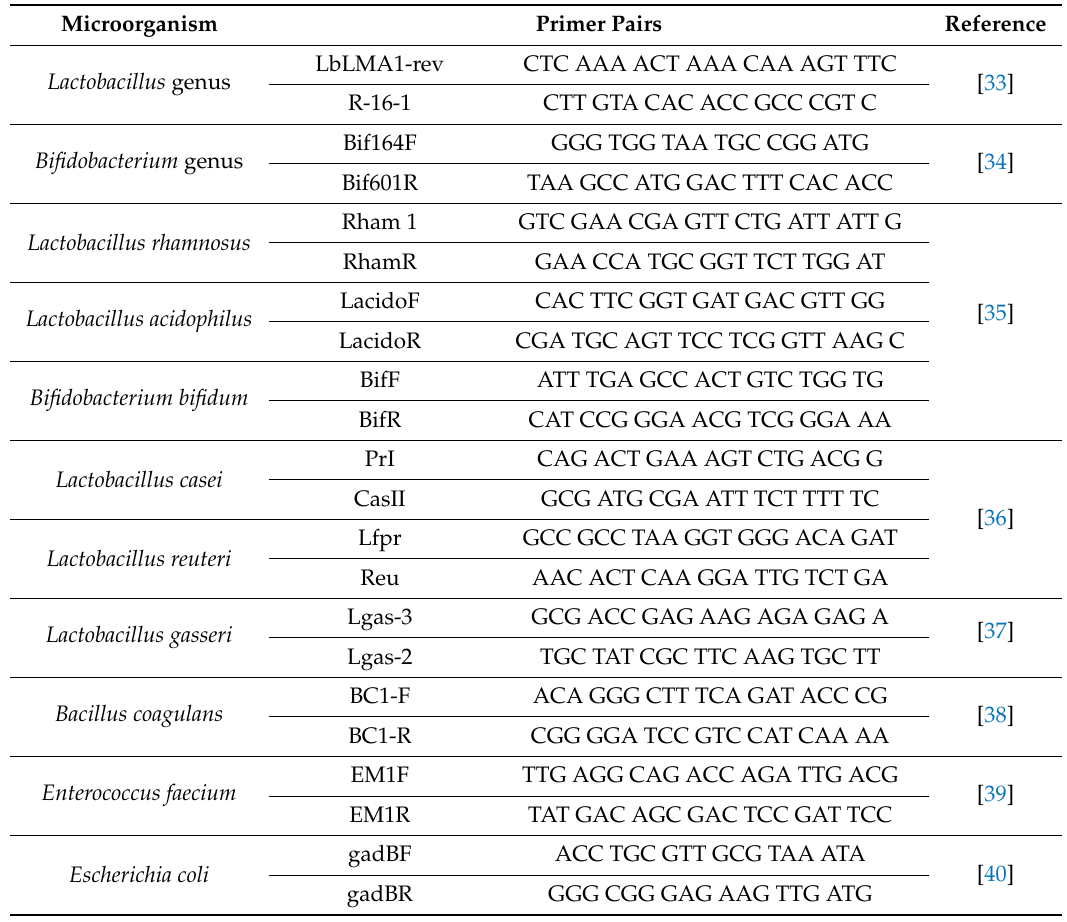
Table 2. Primer pairs of selected probiotics.